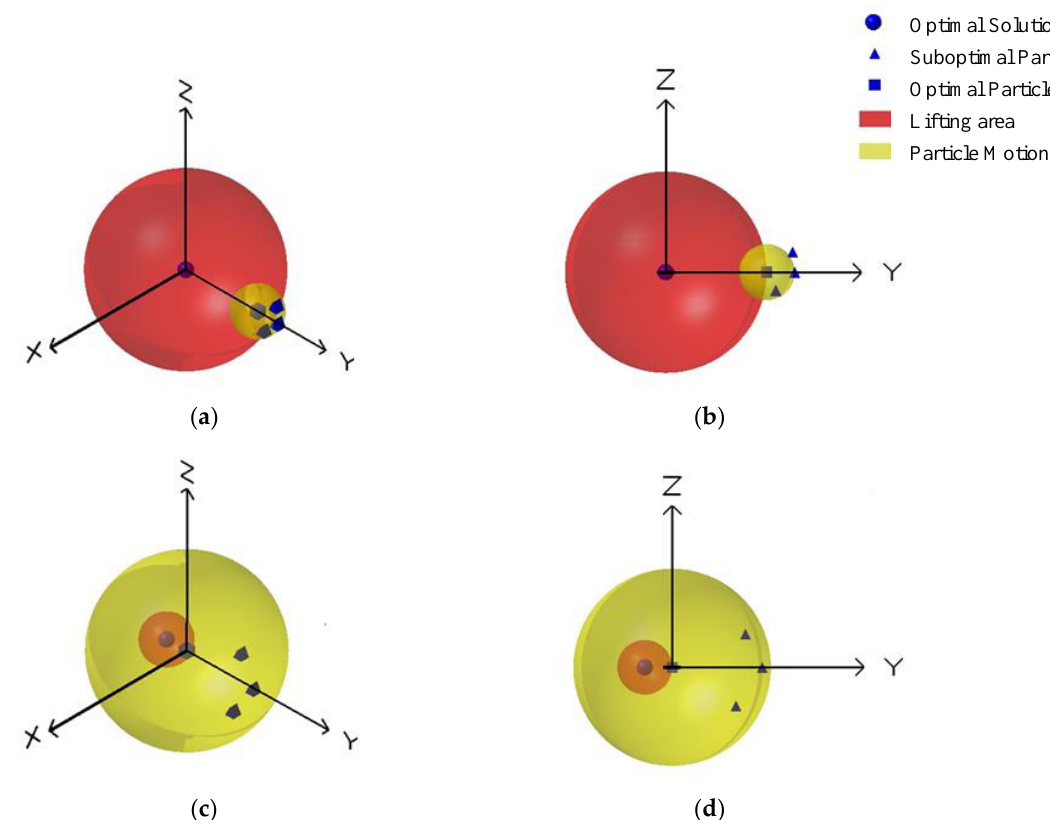
Figure 1. The simplified particle motion model. ( a ) The first case, where the particle swarm is far from the optimal solution, but the particles are close to each other. ( b ) Another perspective of the first case. ( c ) The second case, where the optimal particle is close to the optimal solution and the suboptimal particles also move in the vicinity of the optimal solution. ( d ) Another perspective of the second